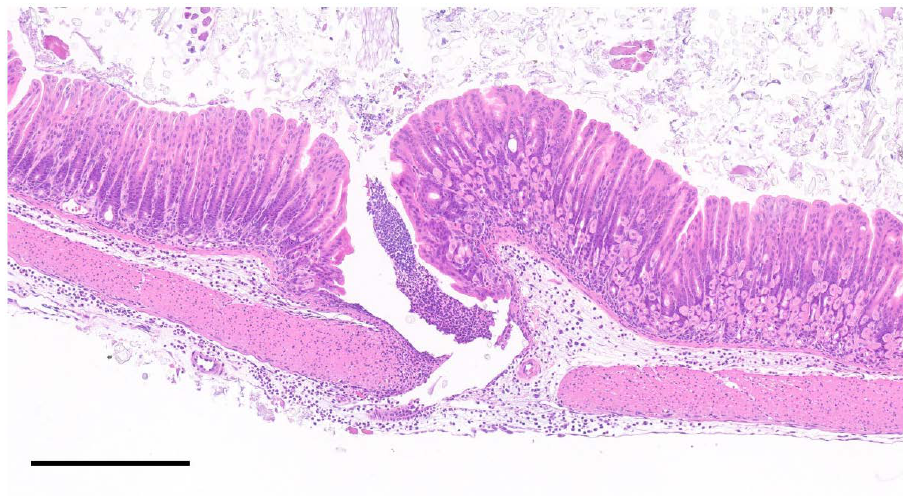
Figure 7. Gastric wall puncture associated with IP injections. Photomicrograph of the gastric wall of a mouse receiving repeated IP injections. The gastric wall has a focal transmural defect filled with a coagulum of neutrophils. Similar inflammatory infiltrates, along with edema expand the submucosa and the serosa. H&E stain. Scale bar, 300 µ m.